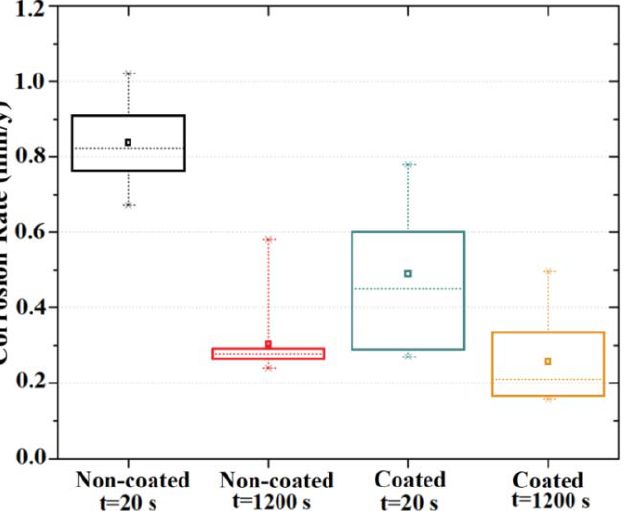
Figure 10. Box plot of the corrosion rate results obtained for non-coated and MgF 2 -coated samples.